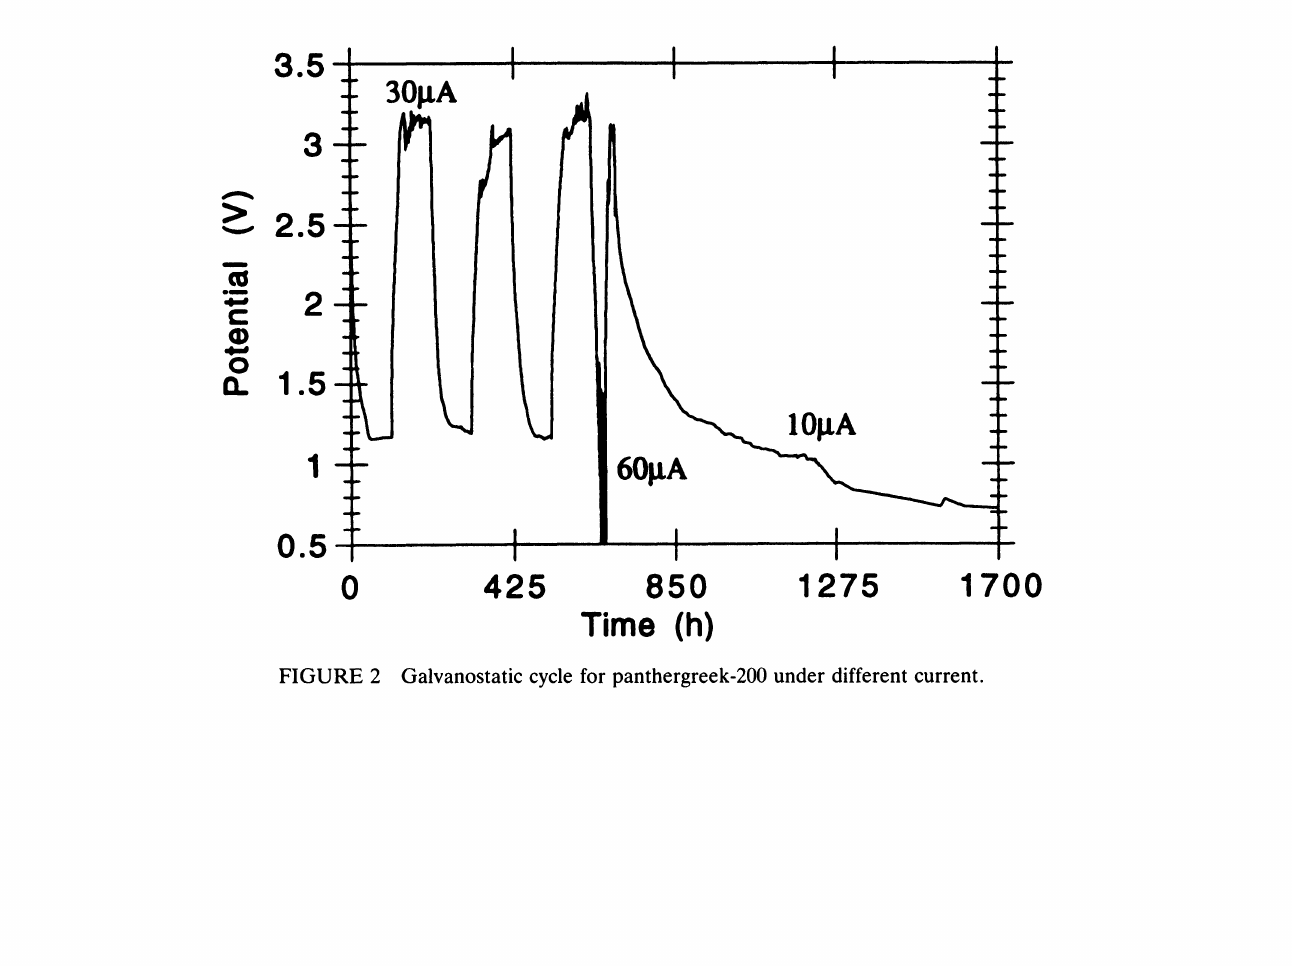
FIGURE 2 Galvanostatic cycle for panthergreek-200 under different